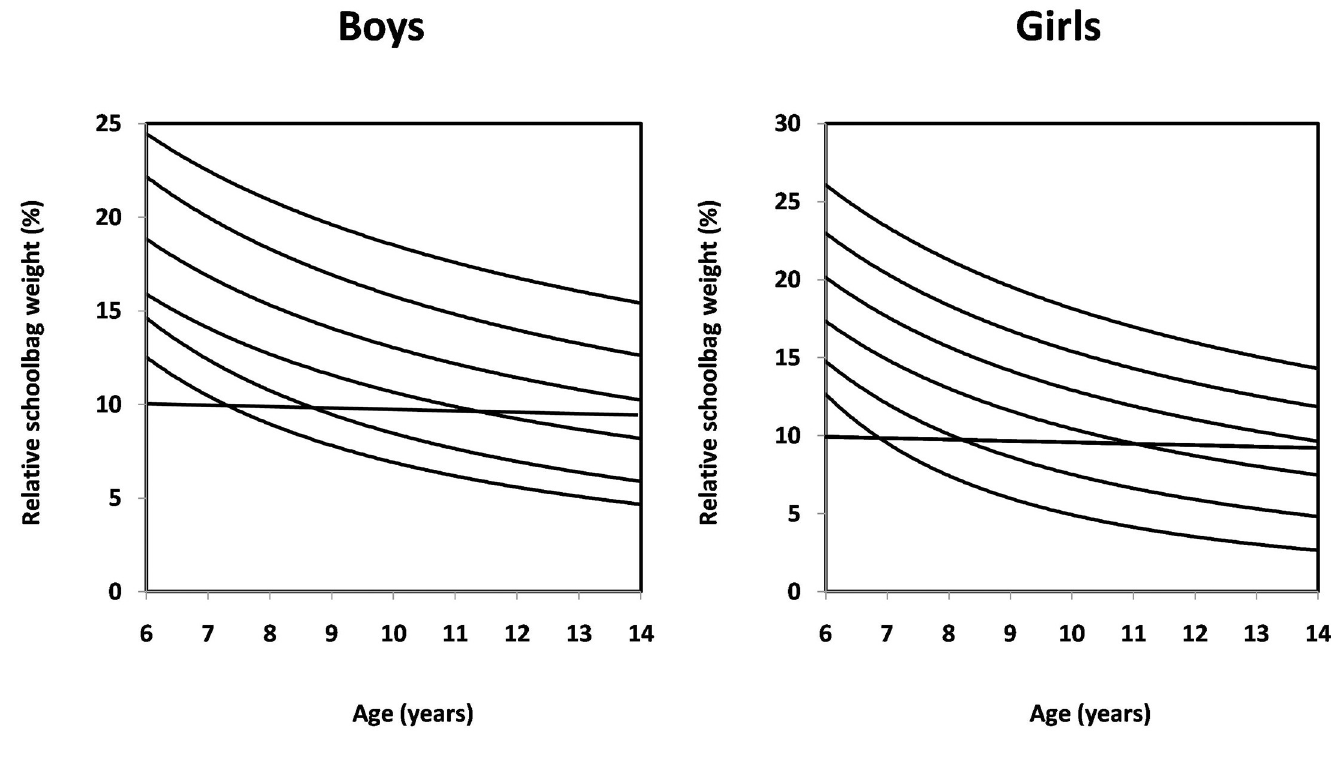
Fig 1. Sex- and age-specific normative values for relative schoolbag weight, Czech Republic.